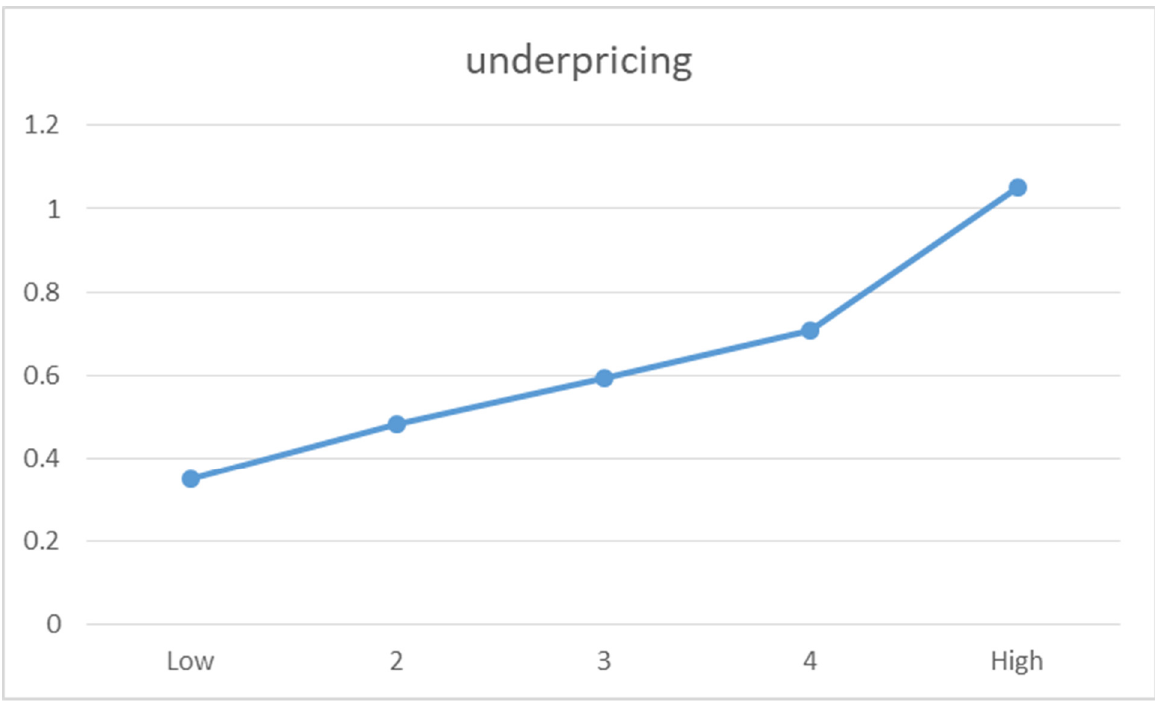
Figure 1. Agreement and Underpricing: Univariate Analysis.